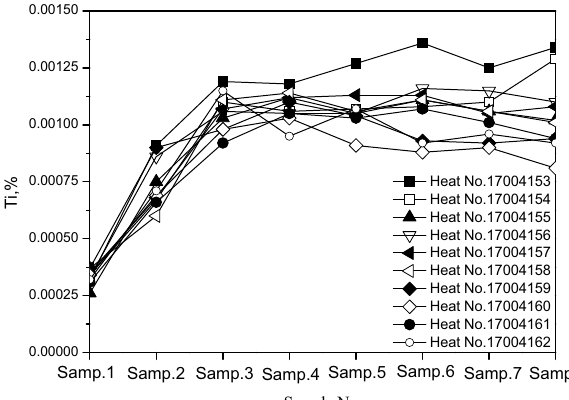
Figure 6: Variation in [ Ti ] content in molten steel during the smelting